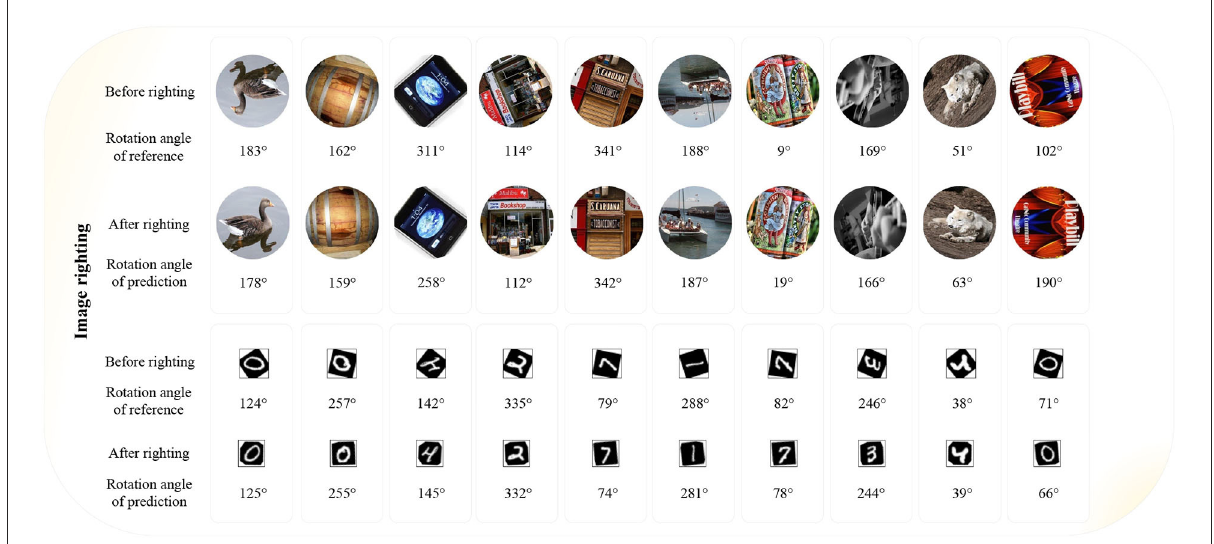
FIGURE10 Examples of image